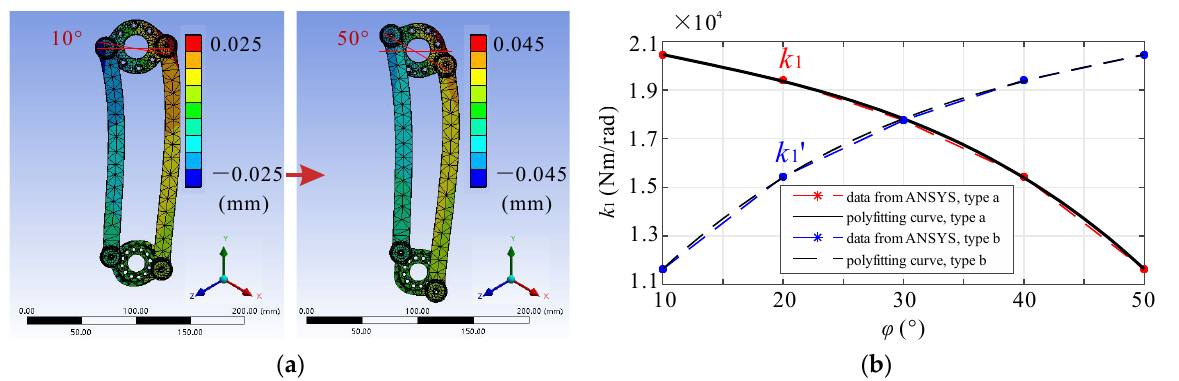
Figure 7. ( a ) Two types of installation of the linkages; ( b ) Stiffness of the linkages regarding different installation types.